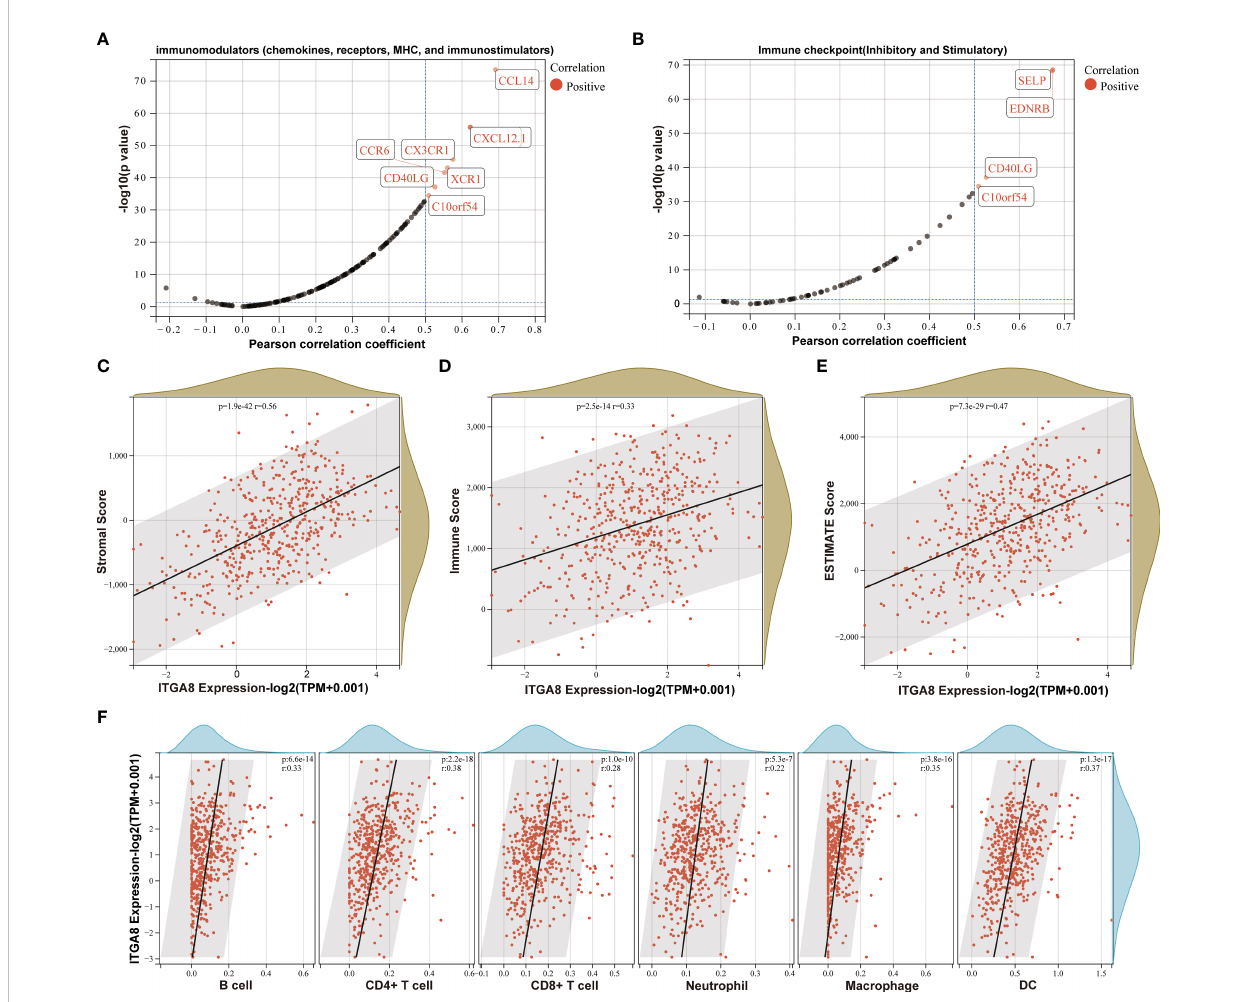
FIGURE 2 The relationship between ITGA8 and the immune microenvironment. (A) Correlation analysis between the expression of ITGA8 and 150 marker genes of fi ve types of immune pathways in LUAD samples. (B) Correlation analysis between the expression of ITGA8 and 60 marker genes of two types of immune checkpoint pathways in LUAD samples. (C) Stromal ( r = 0.56, p < 0.001), (D) immune ( r = 0.33, p < 0.001), and (E) ESTIMATE scores ( r = 0.47, p < 0.001) in each tumor for each patient based on gene expression level. (F) The in fi ltration scores of B cell ( r = 0.33, p < 0.001), CD4+ T cell ( r = 0.38, p < 0.001), CD8+ T cell ( r = 0.28, p < 0.001), neutrophil ( r = 0.22, p < 0.001), macrophage ( r = 0.35, p < 0.001), and DC ( r = 0.37, p < 0.001) in each tumor for each patient based on gene expression level. The expression level of ITGA8 gene was marked as Log 2(TPM+0.001)